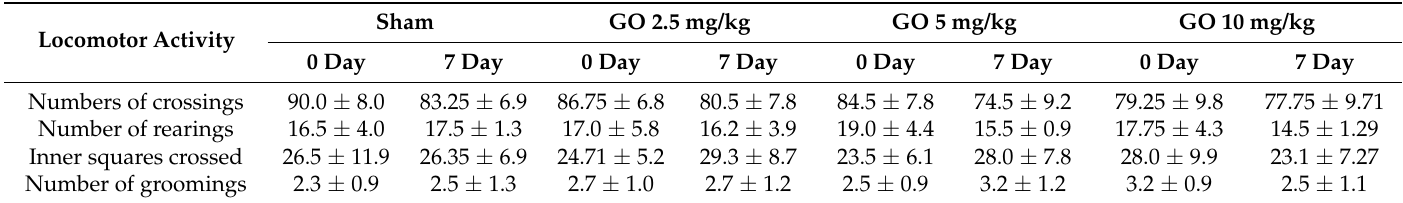
Table 2. Locomotor activity of rats in the open field before or after GO injection.